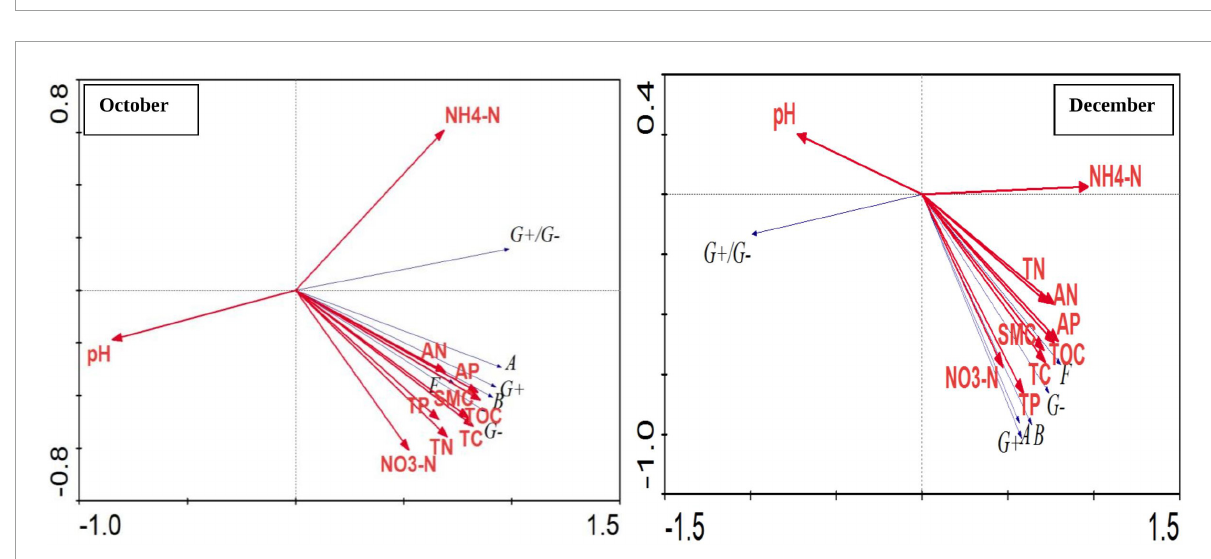
FIGURE5 Correlation between different soil physico-chemical parameters and soil microbial groups based on PLFA content. Where, October and December- Months of soil sampling; G +, Gram-positive bacteria; G– , Gram-negative bacteria; B, Bacteria; A, Actinomycetes; F, Fungi; WC, Water content (%), TOC, Total organic carbon (%), TC, Total carbon (%), TN, Total nitrogen (%), NH 4 N, Ammonium nitrogen (%), NO 3 N, Nitrate nitrogen (%), AN, Available nitrogen (%), TP, Total phosphorus (%), AP, Available phosphorus (%).